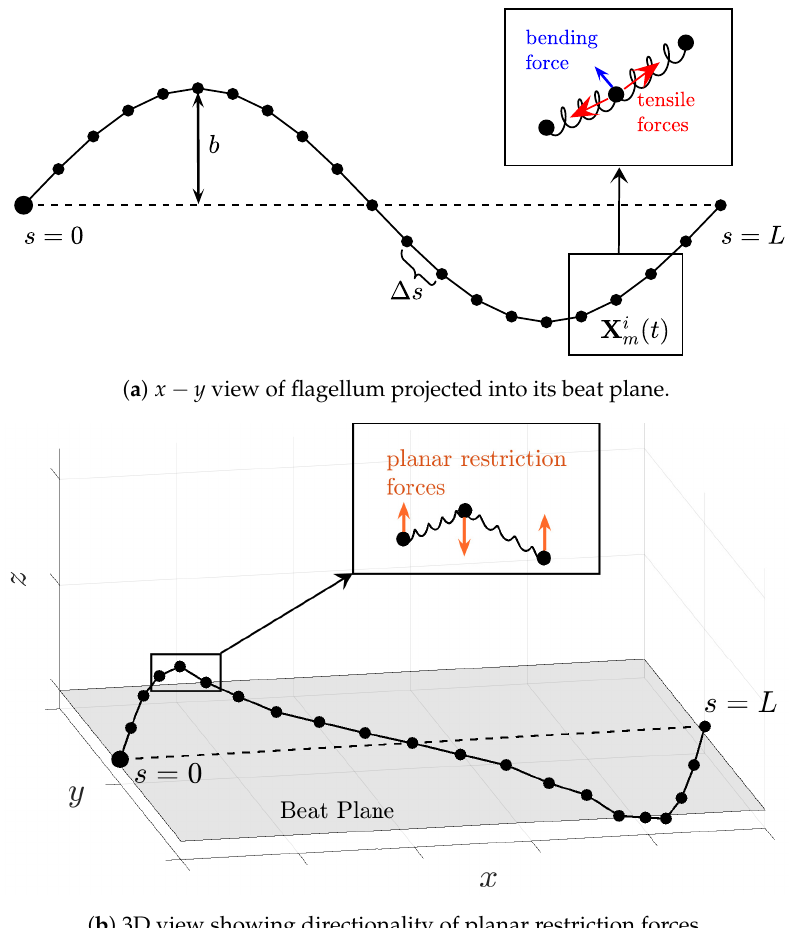
Figure 2. Schematic showing discretization of a flagellum and the forces involved in the